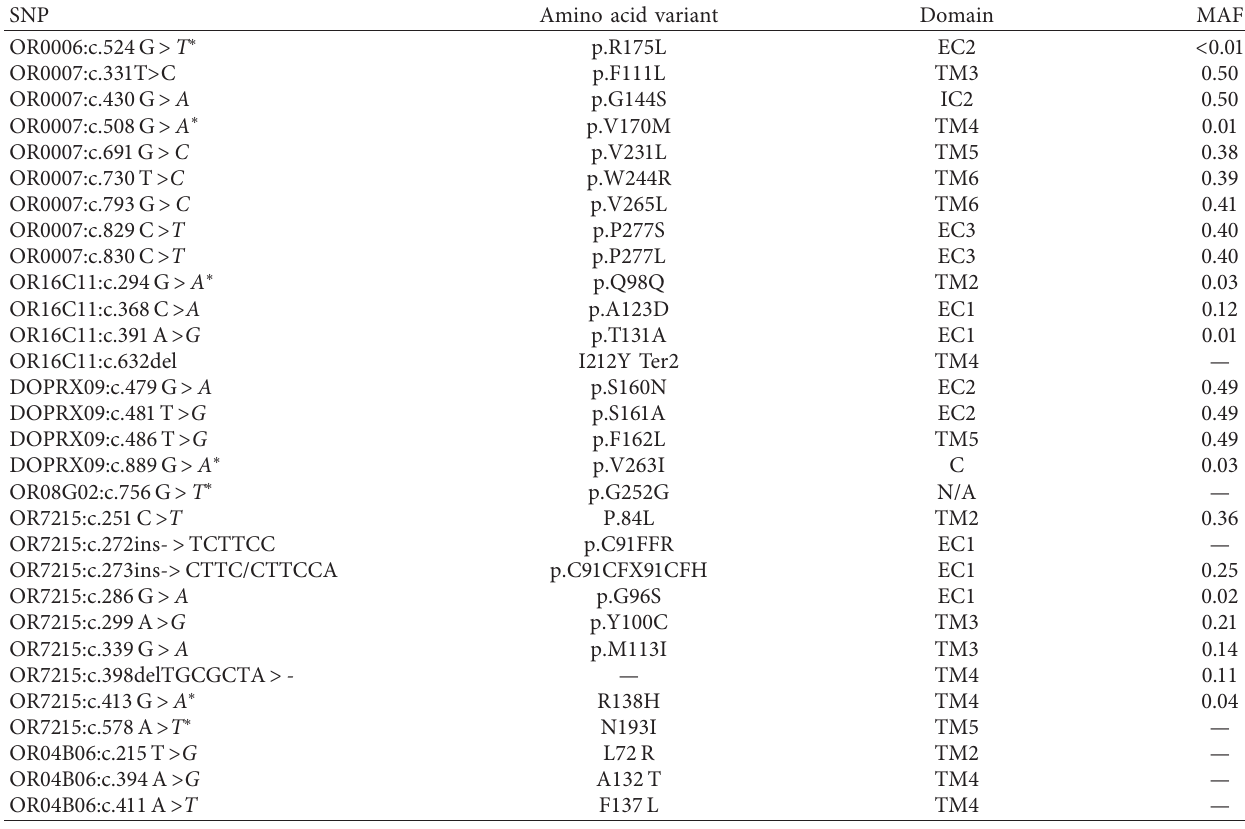
Table 1: Characteristics of the analyzed